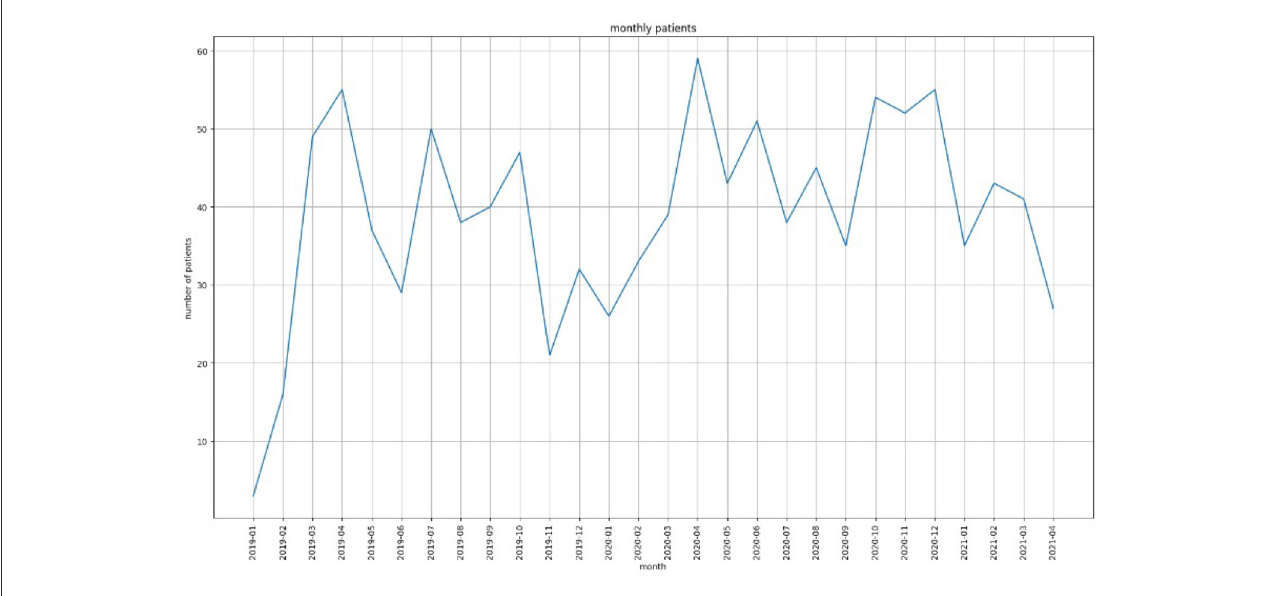
FIGURE1 The number of patients that visited EKOSI Health Centers between January 2019 and March 2021. The highest number of visits recorded was during April